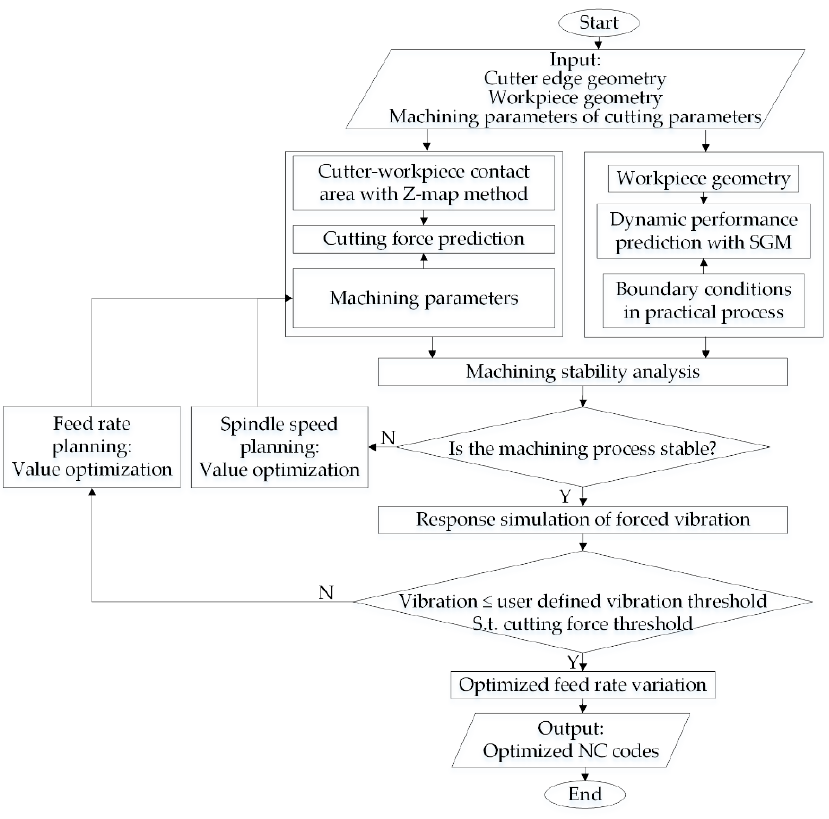
Figure 18. Specific flow diagram of the proposed feed rate variation strategy.